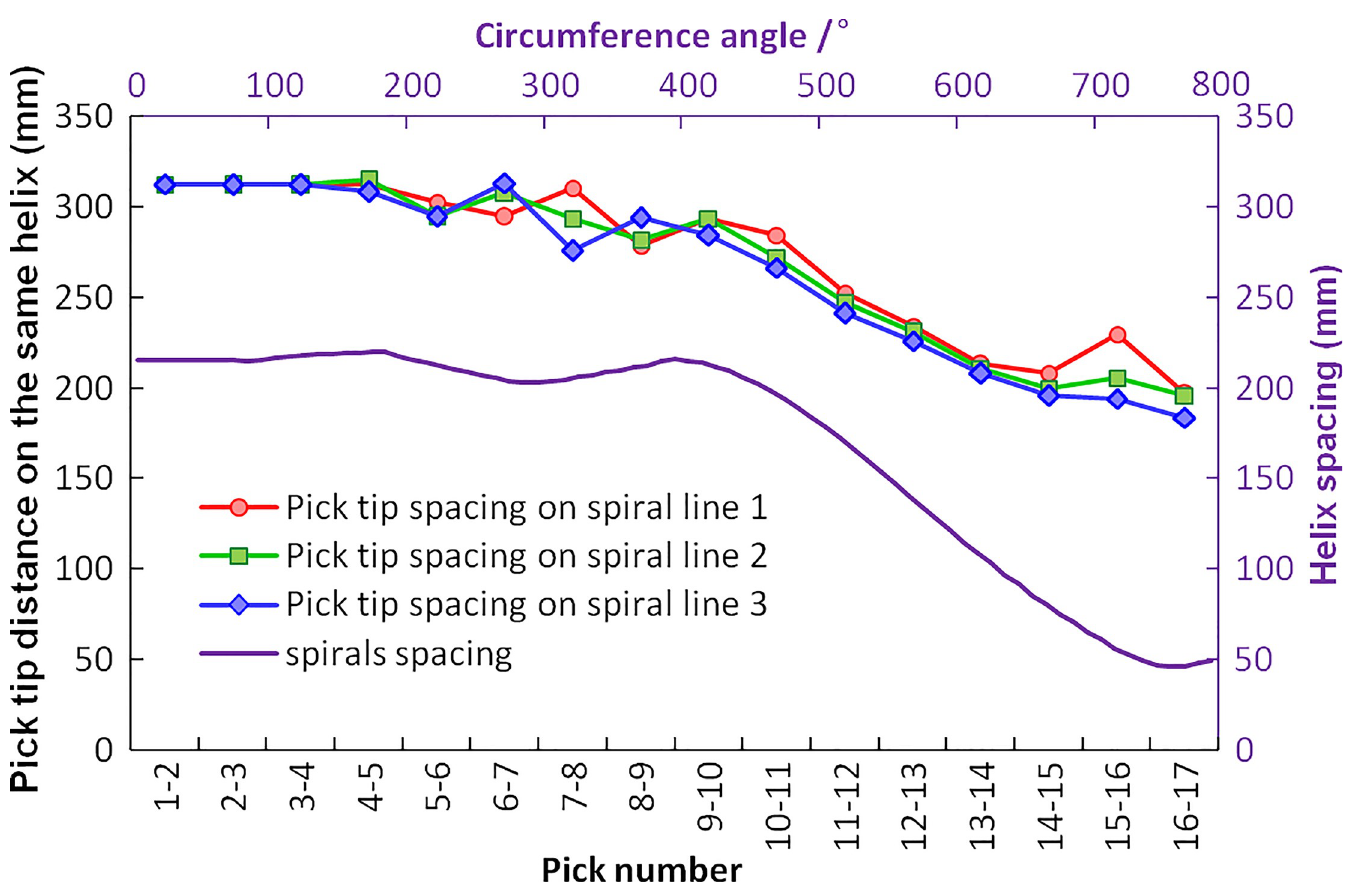
Fig 15. The adjacent helix spacing and the adjacent pick tip distance of CH51 cutting